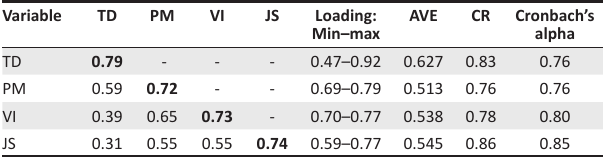
TABLE 3: Correlations, average variance extracted, composite reliability and Cronbach’s alpha values. Variable